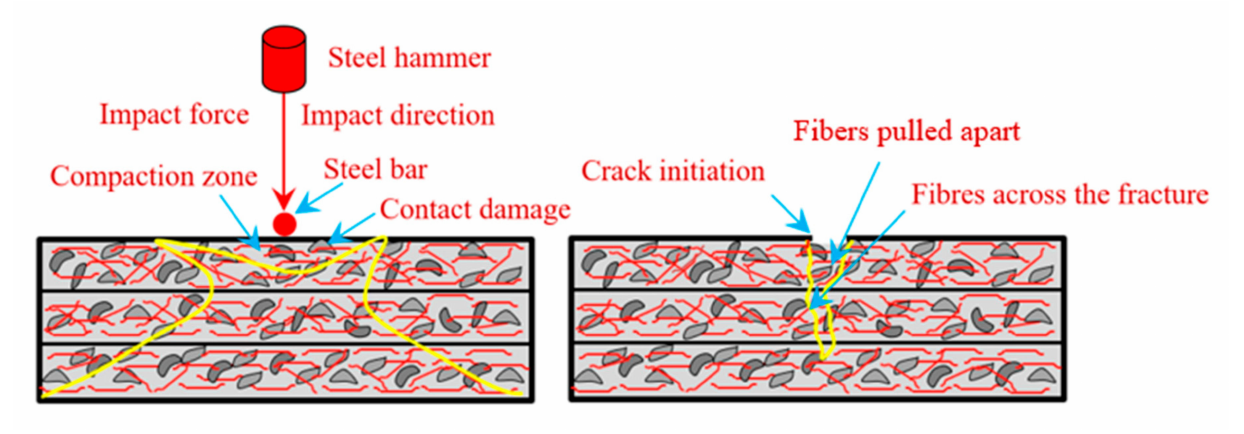
Figure 18. Failure